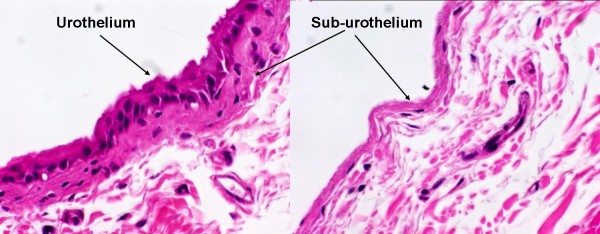
Representative microscopic picture of the intact (left panel) and swabbed (right panel) bladder strips. The slides were stained with H & E. The micrographs were taken with 200 × magnification. Note that in the right panel the urothelium is missing while the suburothelial layer is preserved.